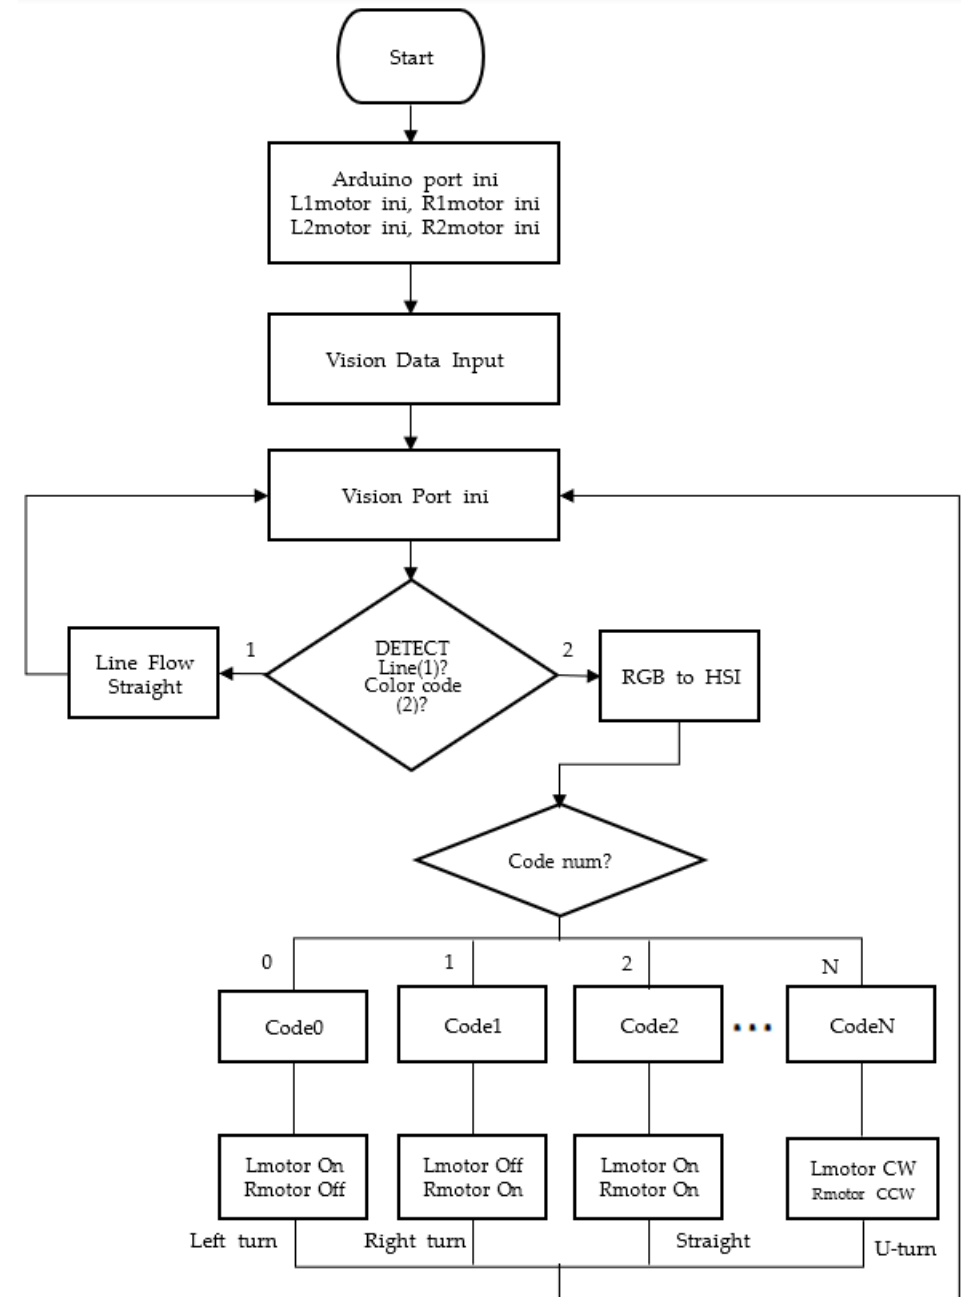
Figure 4. Operating flowchart of the AGVA-Robot.